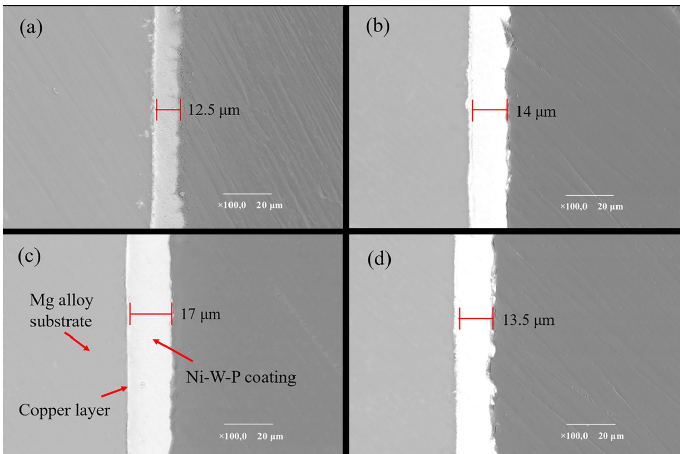
WO concentrations. (a) 5 g/L (b) 10 g/L (c) 15 g/L (d) 20 g/L. 2 4